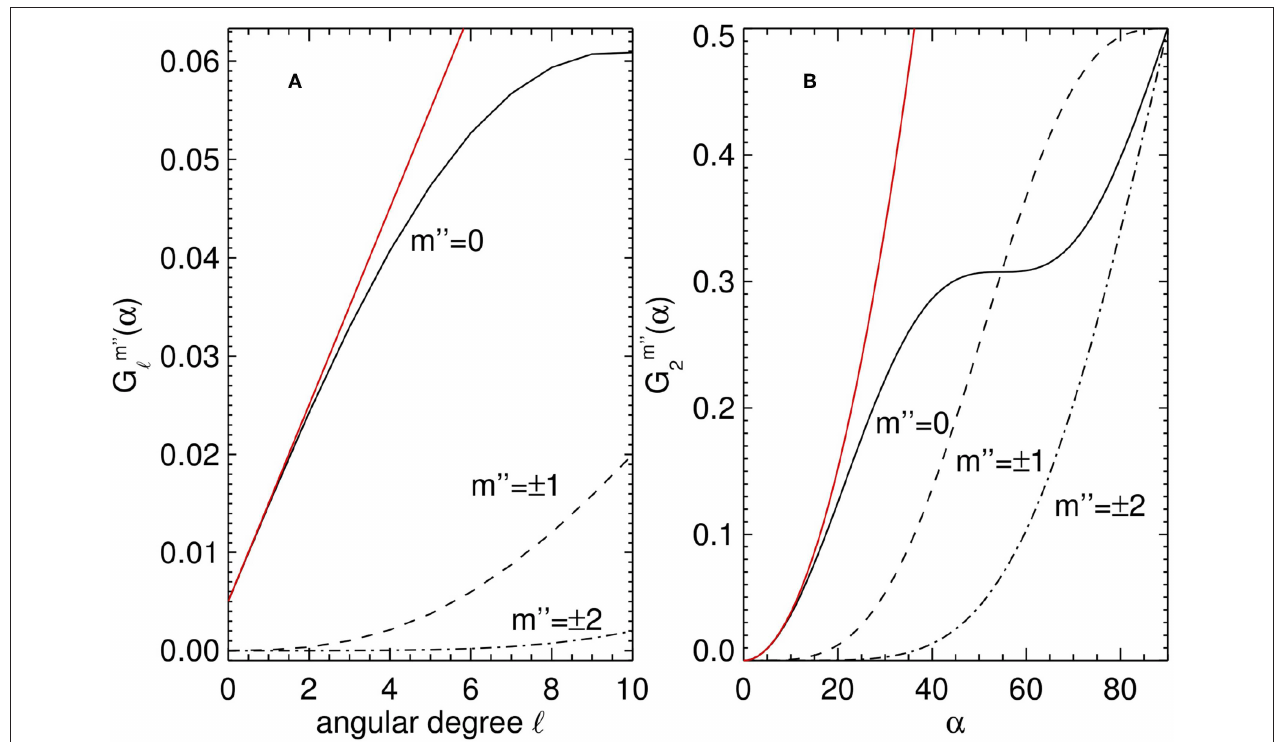
FIGURE 2 | (A) Geometrical weight factor G m ′′ ℓ ( α ) defined by Equation (21) as a function of angular degree ℓ for m = 0, ± 1, ± 2, at fixed α = 8 ◦ . (B) G m ′′ ℓ ( α ) as a function of α for ℓ = 2. The red curves show the parabolic approximations for G 0 ℓ ( α ) in the limit of small α (see section 3.2.3, Equation